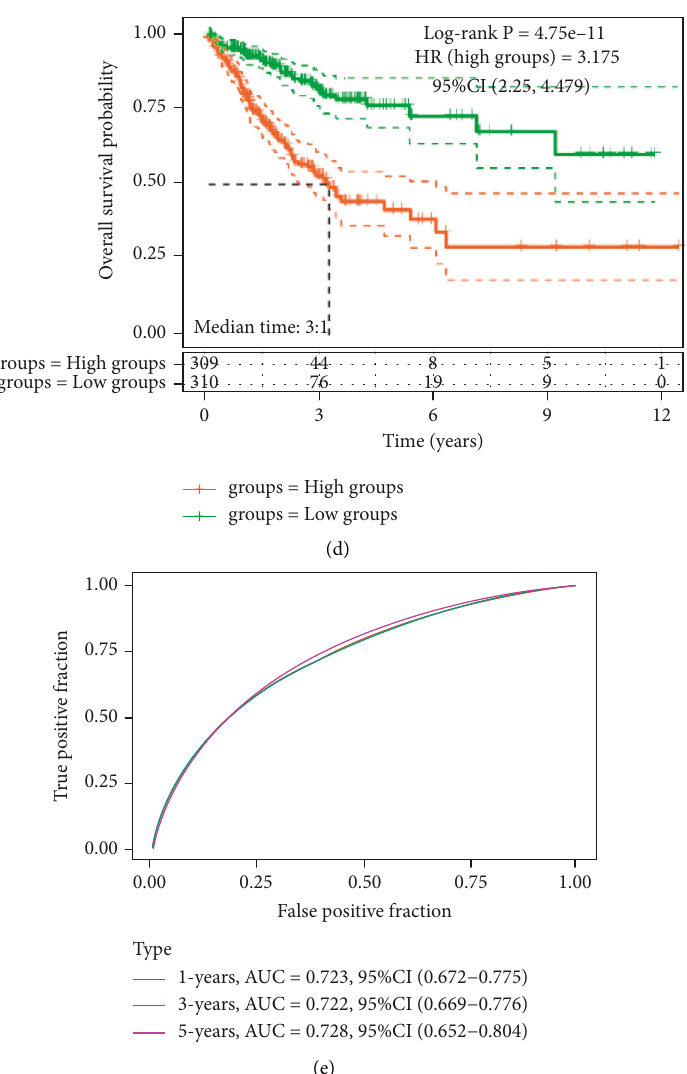
Figure 4: The LASSO analysis and prognostic signature model construction on the 53 mRNAs. (a)-(b) The LASSO regression mode analysis on the 53 mRNAs. (c) The risk score evaluation of CRC patients (top). The corresponding survival time of each patient (middle). The Z-score of expression of 15 candidate prognostic mRNAs (bottom). (d) Prognostic analysis of high-risk and low-risk groups. (e) The ROC curve